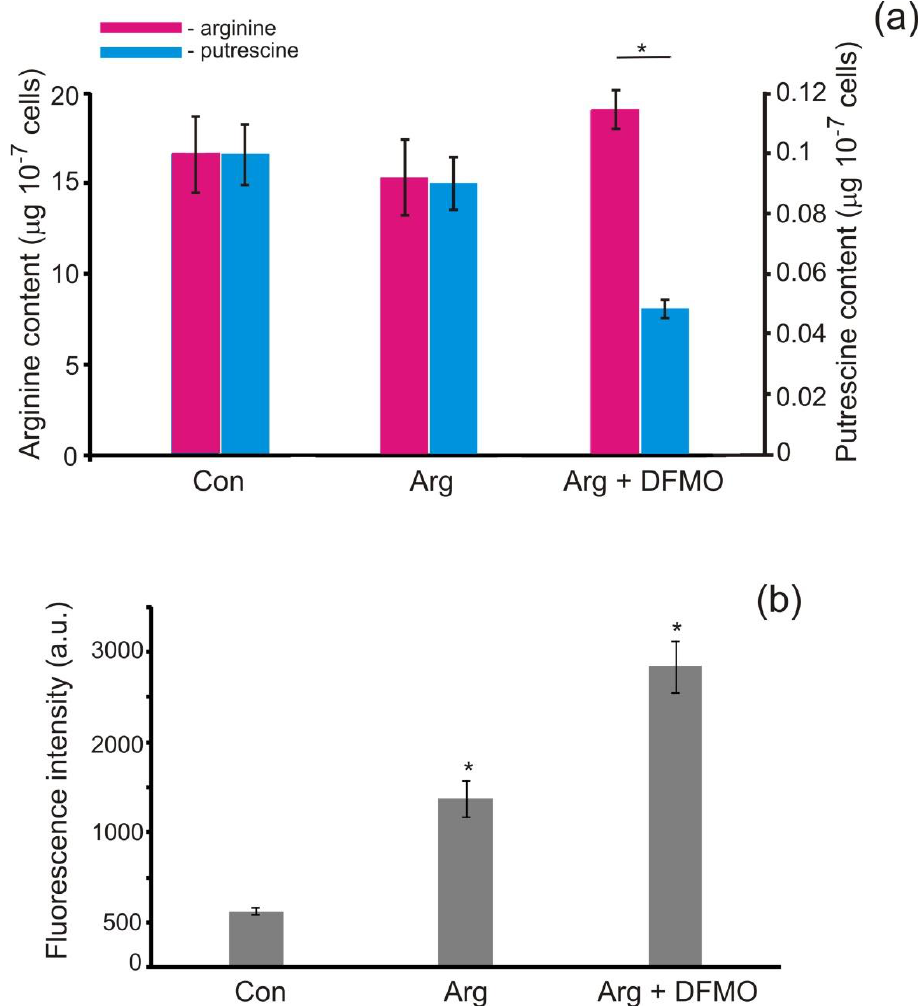
Figure 4. Effects of DFMO on the arginine and putrescine contents ( a ) and intracellular NO generation ( b ). Cells were grown in REP (Con) or incubated in acetate-containing medium with 1 mM arginine in the presence and absence of 1 mM DFMO for 3 h. Arginine and putrescine contents are expressed as µ g in 10 7 cells. Fluorescence intensity due to NO formation was determined using 1 µ M DAF-FM and expressed as arbitrary units per 10 6 cells. Cell autofluorescence was subtracted from the total fluorescence obtained. Means ± SEs of three biological replicates. * denotes significant differences between control (Con) and test variants according to the Student’s t test ( p value < 0.01). The activity of ornithine decarboxylase can be inhibited by the irreversible competi- tive inhibitor difluoromethylornithine (DFMO) [39] We then measured the putrescine contents in the presence of DFMO (Figure 4a). Notably, after the addition of DFMO, a lower amount of putrescine was detected in the cells as compared with the control. Hence,